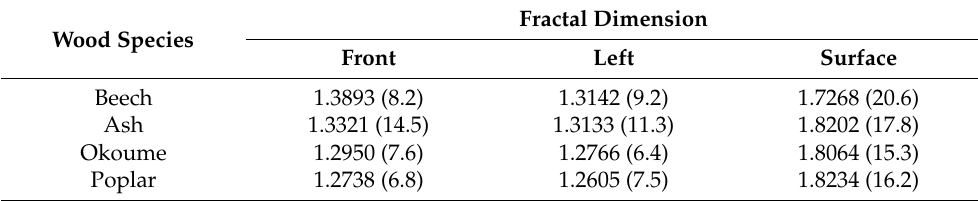
Figure 7. Photos of failure modes and grayscale images of mode I fracture in RL crack propagation systems subjected to compact tension load, ( a ) ash, ( b ) beech, ( c ) okoume, and ( d ) poplar. Table 4. Fractal dimensions of cracks lines and surfaces of four wood species